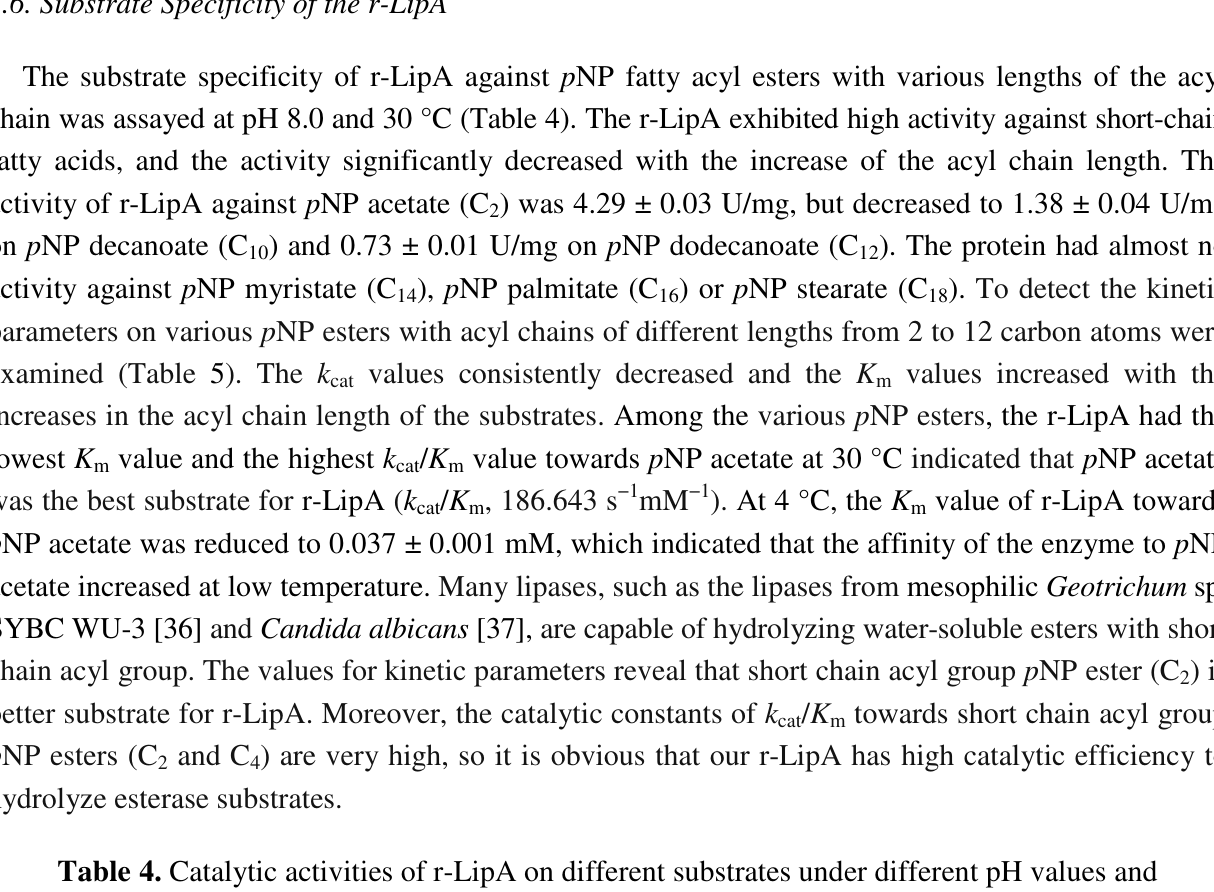
HPO /0.1 M citric acid, 2 4